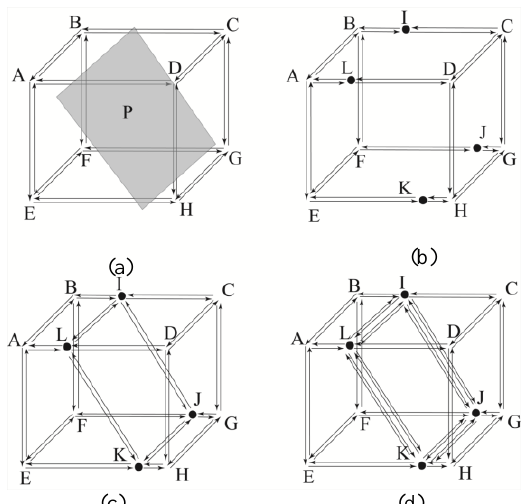
Figure 3. Workflow of space partitioning with a splitting plane: (a) bounding box ABCDEFGH and given splitting plane P; (b) newly generated vertices I, L, J and K; (c) newly generated edges IL, IJ, JK and LK; (d) newly generated face LIJK.